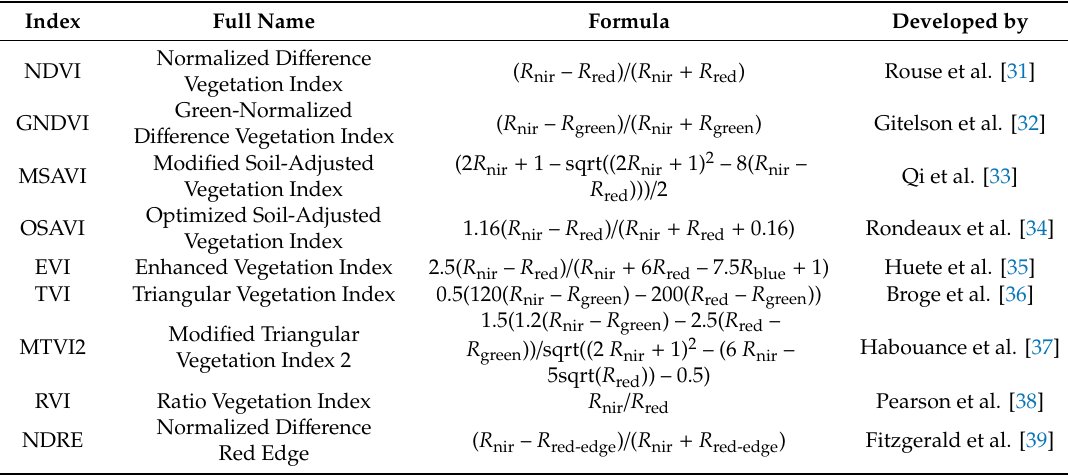
Table 3. Summary of the spectral indices employed in this